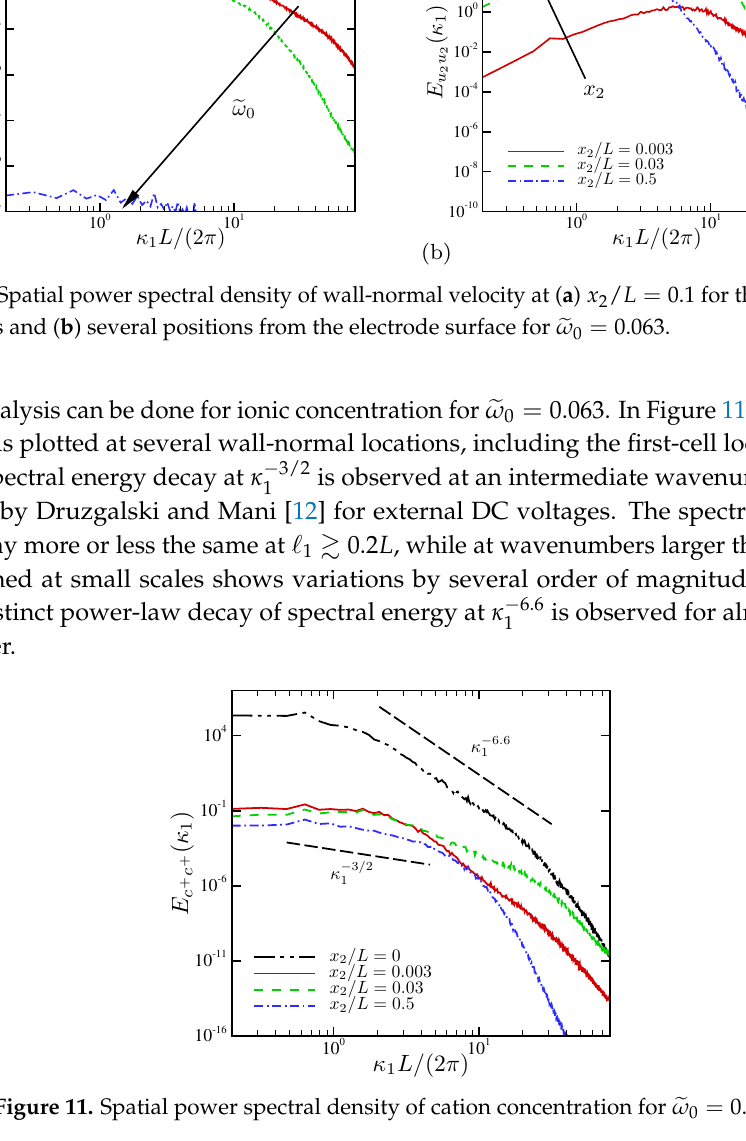
ω 0 = 0.063. (cid:101)